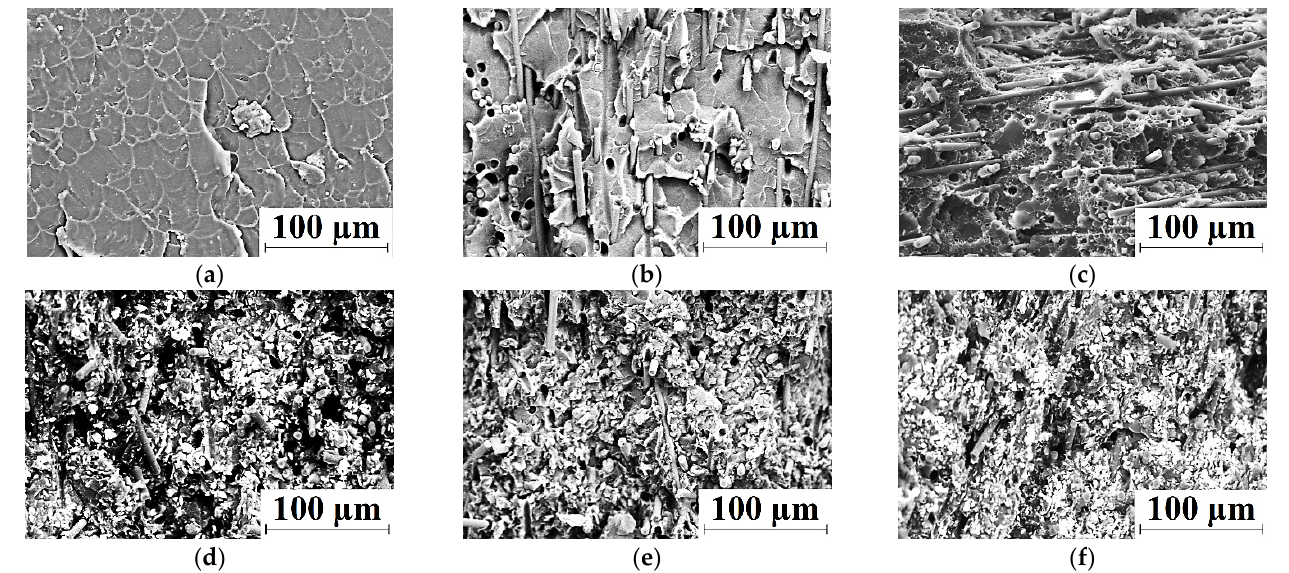
Figure 3. SEM-micrographs illustrating the structure for neat PI ( a ), as well as the PI/10CCF ( b ), PI/10CCF/10PTFE ( c ), PI/10CCF/10MoS 2 ( d ), PI/10CCF/10Gr ( e ), and PI/10CCF/23MoS 2 ( f ) composites.